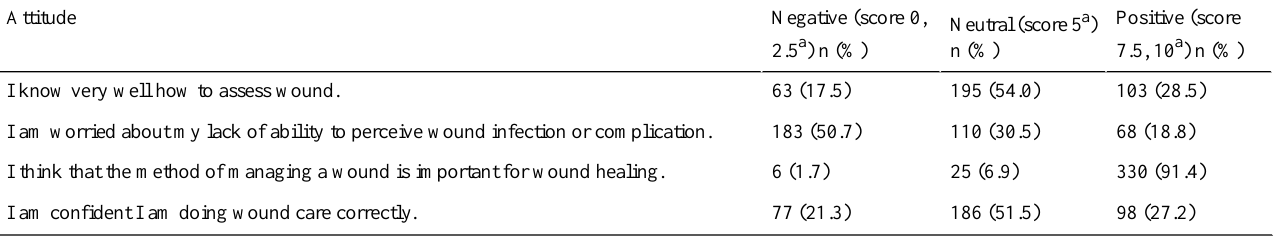
Table 4. Wound care attitudes (n=361).